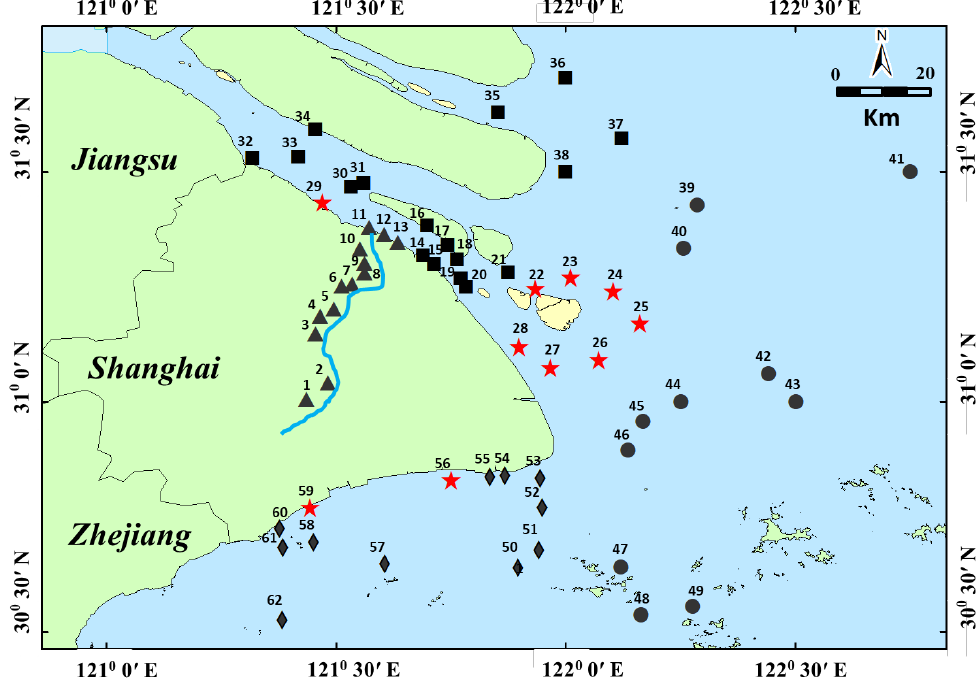
Figure 1. The map shows the sampling points of surficial sediments ( ▲ , ■ , ● , ◆ and ★ ) collected from Shanghai offshore areas ( ▲ was collected from Huangpu River, ■ was collected from the Yangtze Estuary, ● was collected from East Sea Coastal, ◆ was collected from Hangzhou Bay, and ★ was collected from the sediment dropping area. Most of the Sediment was from the Huangpu River).